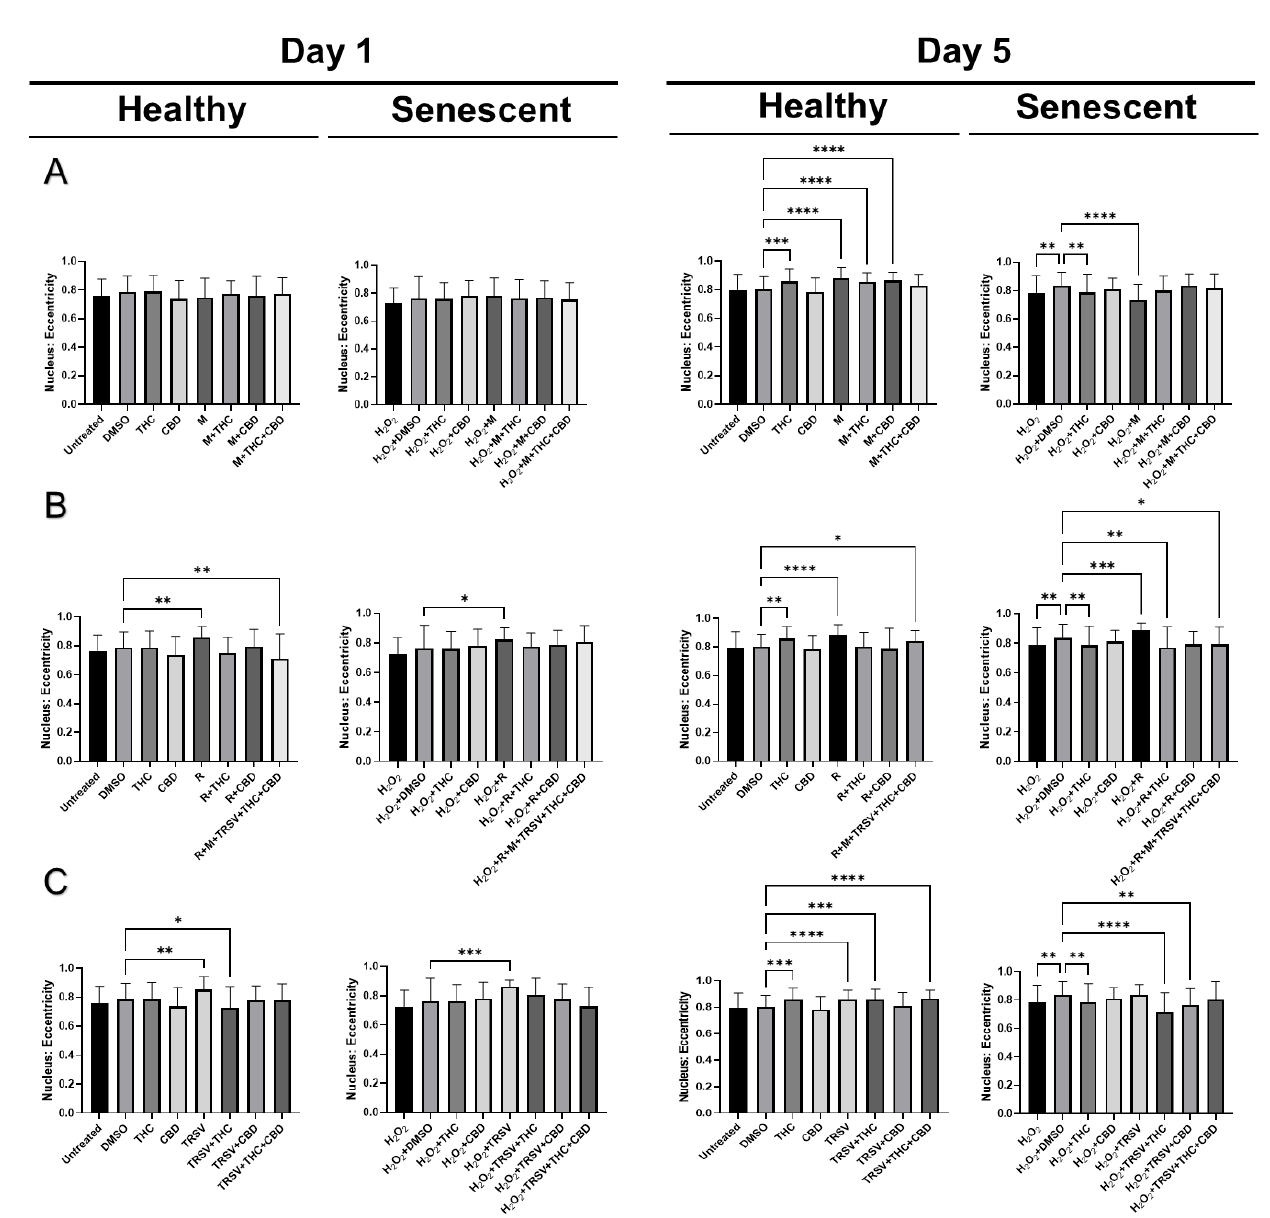
Figure 11. DAPI stained nuclei eccentricity parameters of skin fibroblasts CCD-1064Sk (p.11) exposed to metformin, triacetylresveratrol, and rapamycin combined with pCBs. Nuclear parameters were observed by immunofluorescence microscopy for: healthy and senescent fibroblasts treated with ( A ) 500 μM metformin, ( B ) 5 μM rapamycin, or ( C ) 10 μM triacetylresveratrol and combinations with pCBs compared to 2 μM of THC, 2 μM of CBD, DMSO, and untreated fibroblasts after 1 day and 5 days of exposure . Data were analyzed with a one-way ANOVA test followed by a Dunnett’s post hoc test compared to the DMSO or H 2 O 2 + DMSO control. Bars represent mean ± SD. Significance is indicated within the figures using the following scale: * p < 0.05, ** p < 0.01, *** p < 0.001, **** p < 0.0001. CBD, cannabidiol; DMSO, dimethyl sulfoxide (vehicle), M, metformin; R, rapamycin; THC, Δ -9-tetrahydrocannabinol; TRSV, triacetylresveratrol.